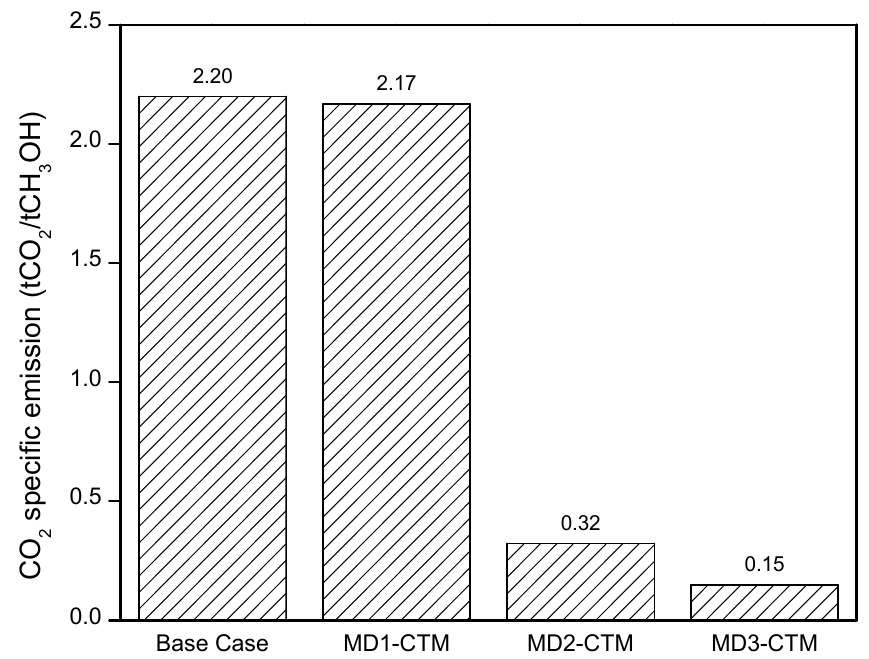
Figure 10. CO 2 specific emissions for the four CTM processes.